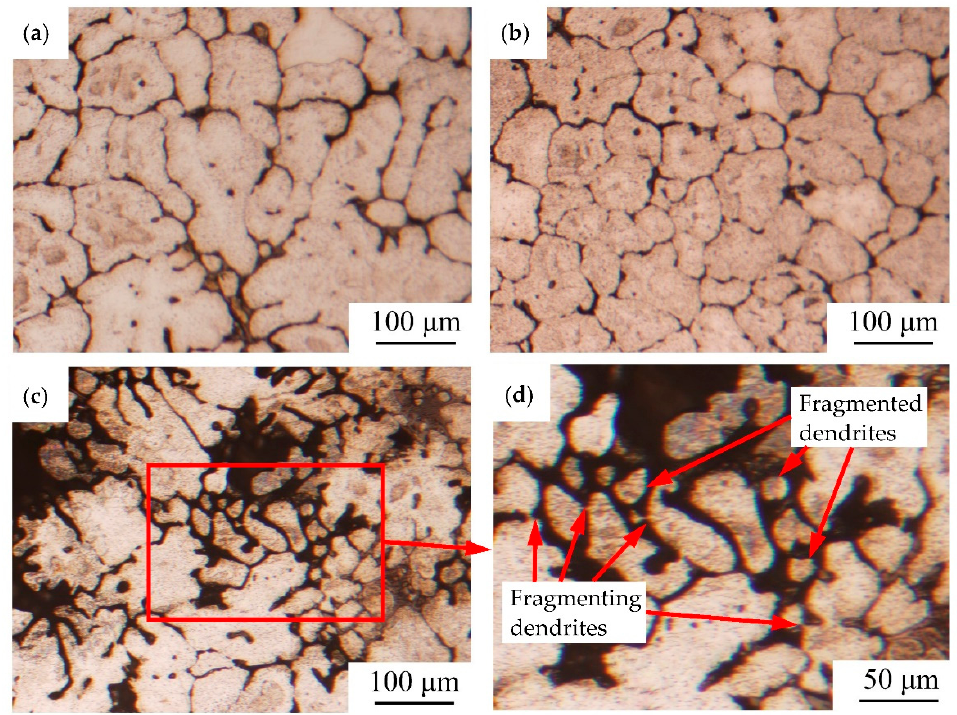
Figure 13. Optical micrographs of the center of the feeding channels: ( a ) sample 1; ( b ) sample 2; ( c ) sample 3; ( d ) partial enlargement of sample 3.